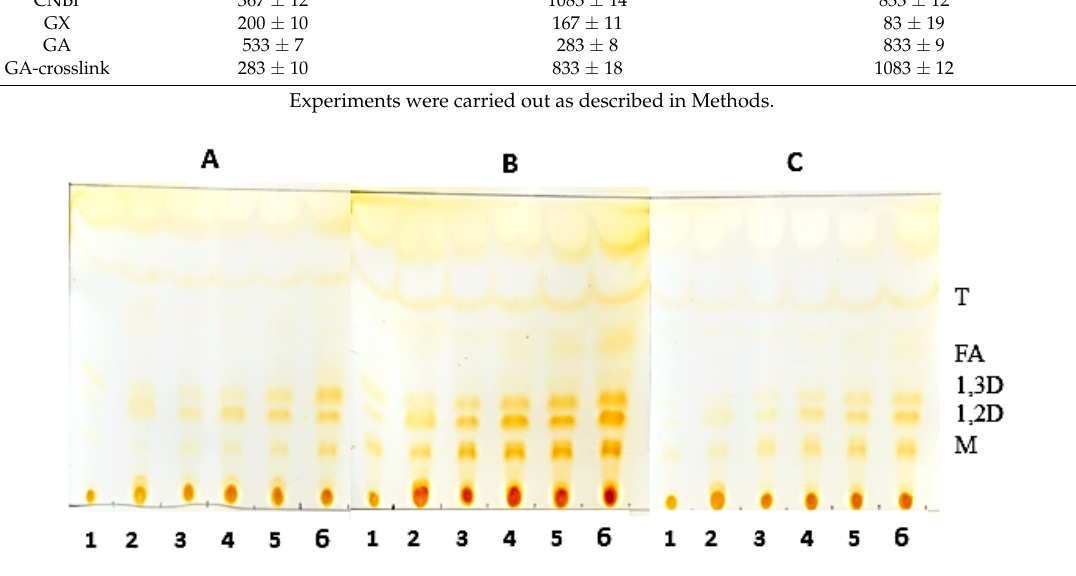
Figure 4. Thin-layer chromatography of the hydrolysis products of oils catalyzed by lipase derivatives. ( A ) Açaí oil; ( B ) Cotton seed oil; ( C ) Grape seed oil. 1: Reaction without enzyme; 2: free lipase; 3: CNBr